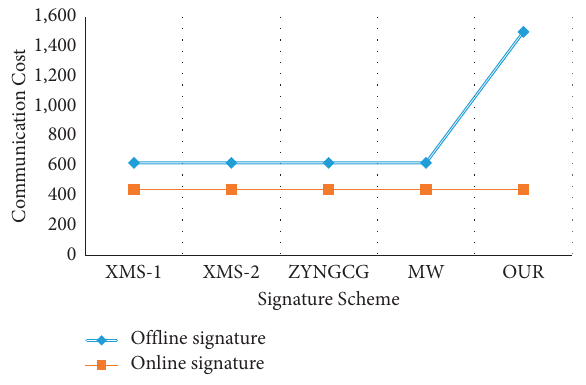
Figure 10: Communication cost